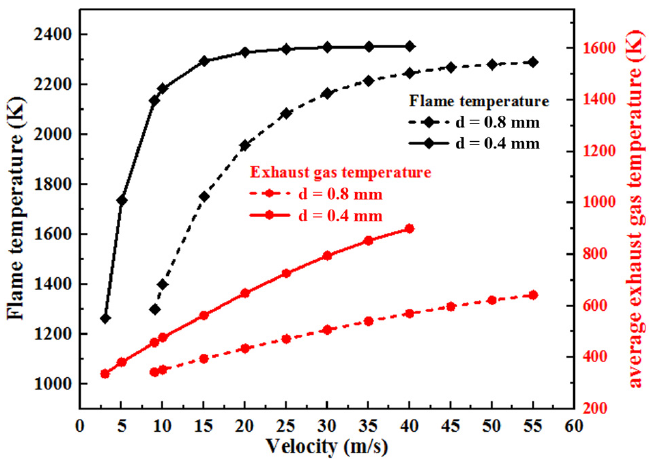
Figure 7. Temperature variations of flame and exhaust gas with jet velocity.